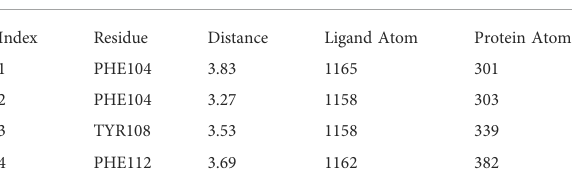
TABLE 2 The hydrophobic interaction between Complex 5 and Bcl-2.